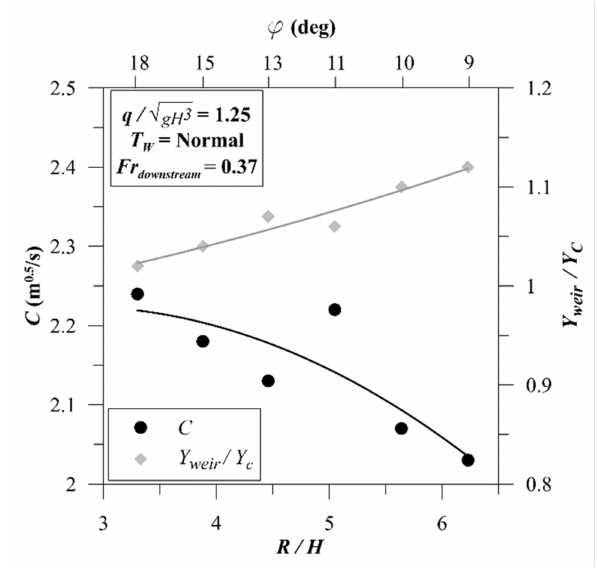
Figure 5. Weir coefficient and relative depth for ramps of different